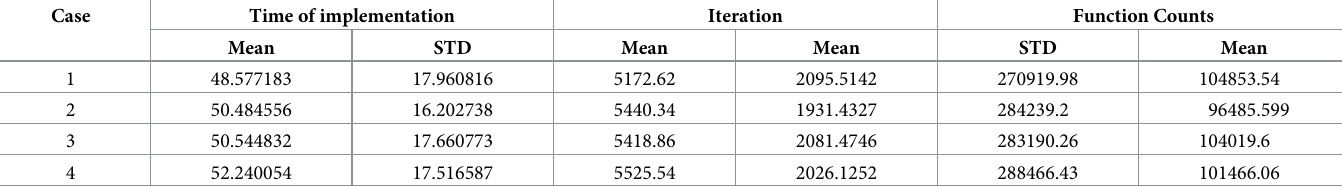
Table 7. Complexity representations for problem